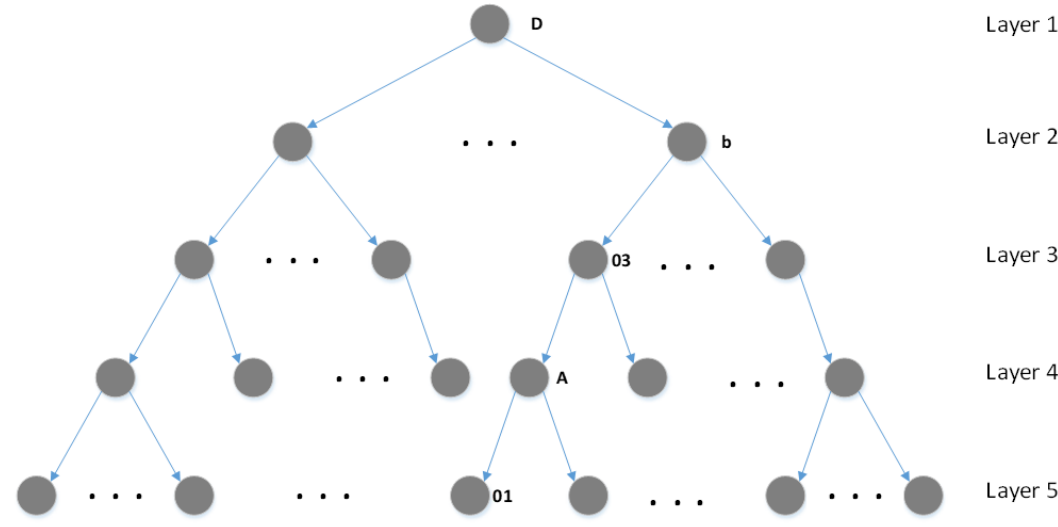
Figure 2. The five layers in HIT IR-Lab Tongyici Cilin.